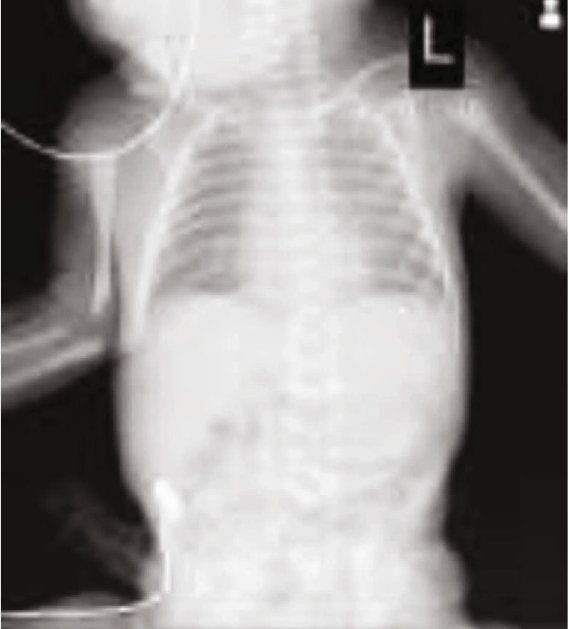
Figure 1: Chest radiograph of preterm infant with respiratory distress syndrome (RDS).